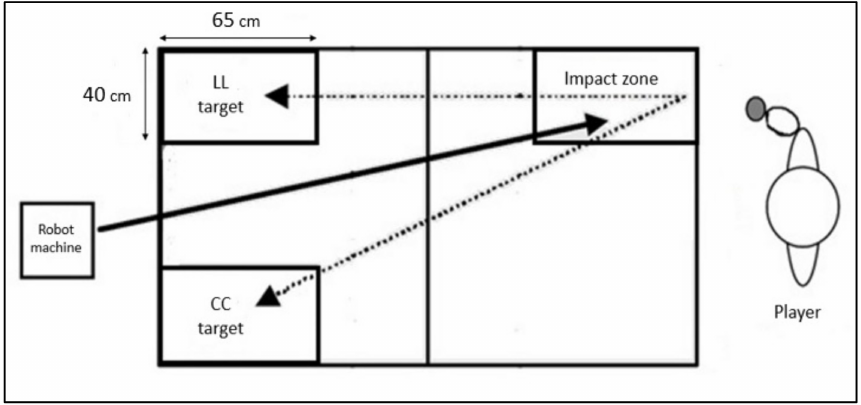
Figure 2. Experimental set-up of the